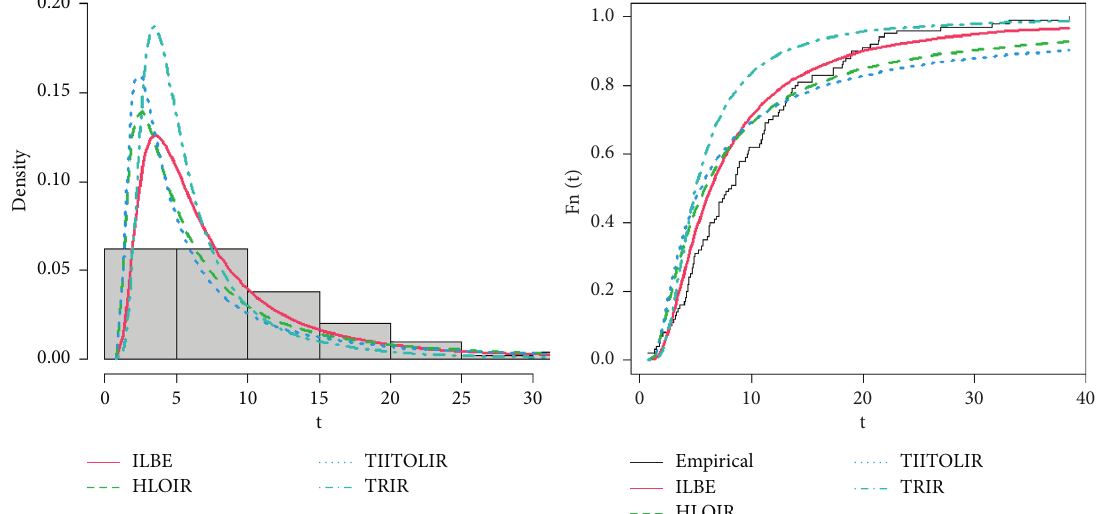
Figure 3: Fitted PDFs and CDFs of comparison models for the second